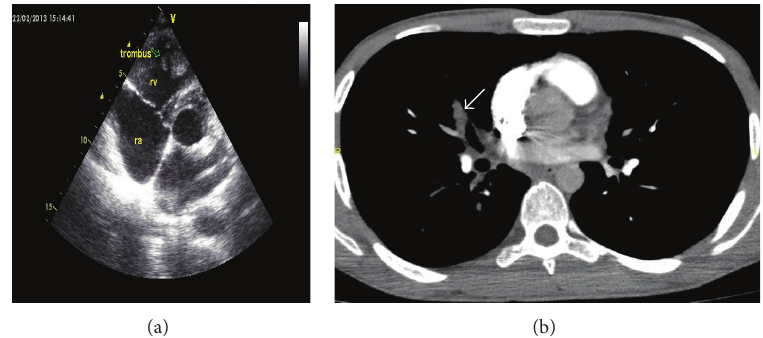
Figure 2: (a) Transthoracic echocardiography in the parasternal short-axis view shows a thrombus (arrow) in the right ventricle attached to the interventricular septum. (b) Contrast-enhanced pulmonary CT angiography shows acute embolus filling and mildly enlarging the right middle lobe artery